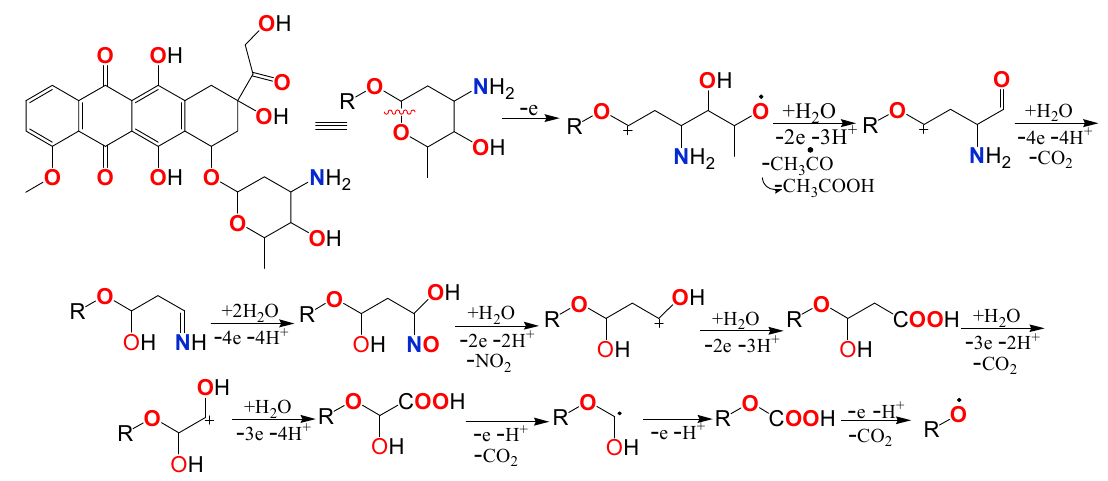
Scheme 1. The formation of the intermediate radical of tetracene structure.